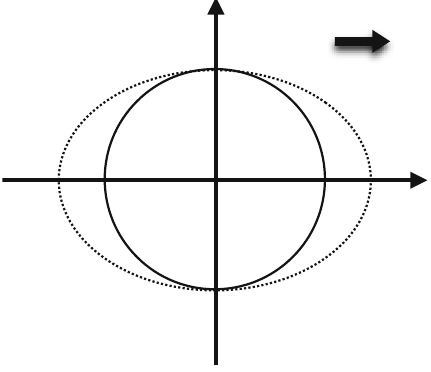
Fig. 1 Diagram for the effects of a Ψ 2 -polarized wave when passing through a ring of test particles. The black arrow in the upper right indicates the direction of propagation of the